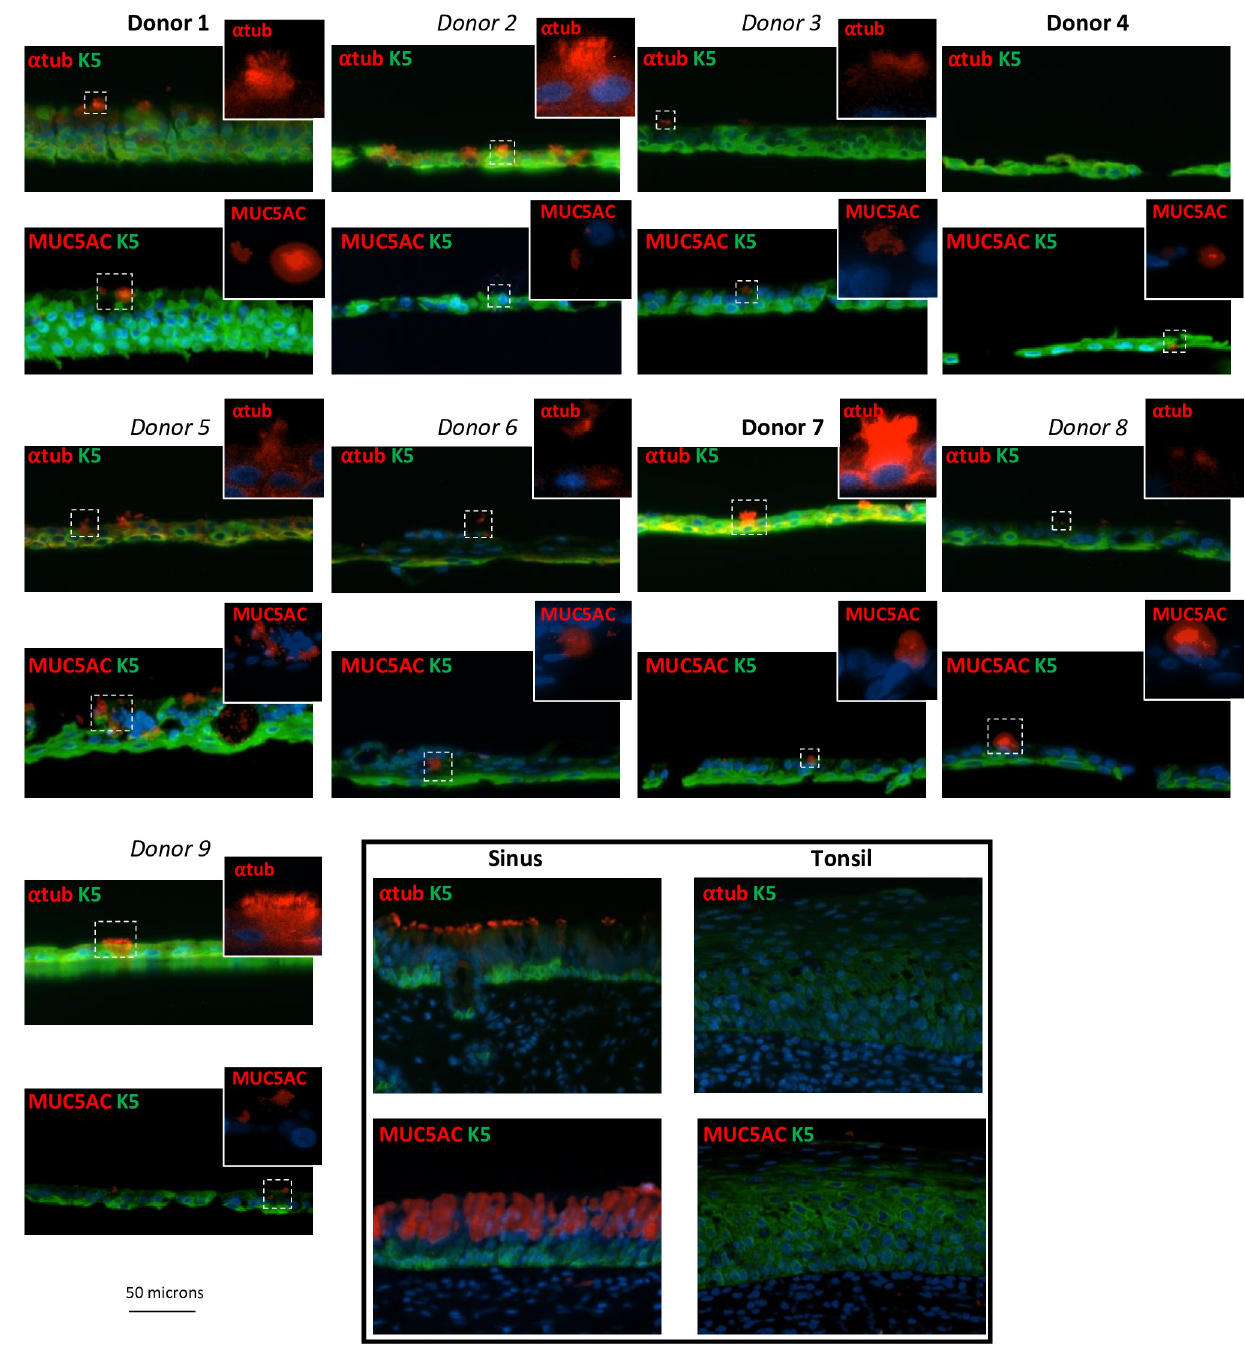
Fig 4. Immunostaining for cell-type specific markers unique associated with the pseudostratified epithelium. Immunofluorescence images of FFPE sections from pseudo-ALI cultures stained for cilia ( α -tubulin) and for a mucosecretory Goblet cell marker (MUC5AC). Sinus and tonsil sections served as positive and negative tissue controls, respectively. K5, keratin